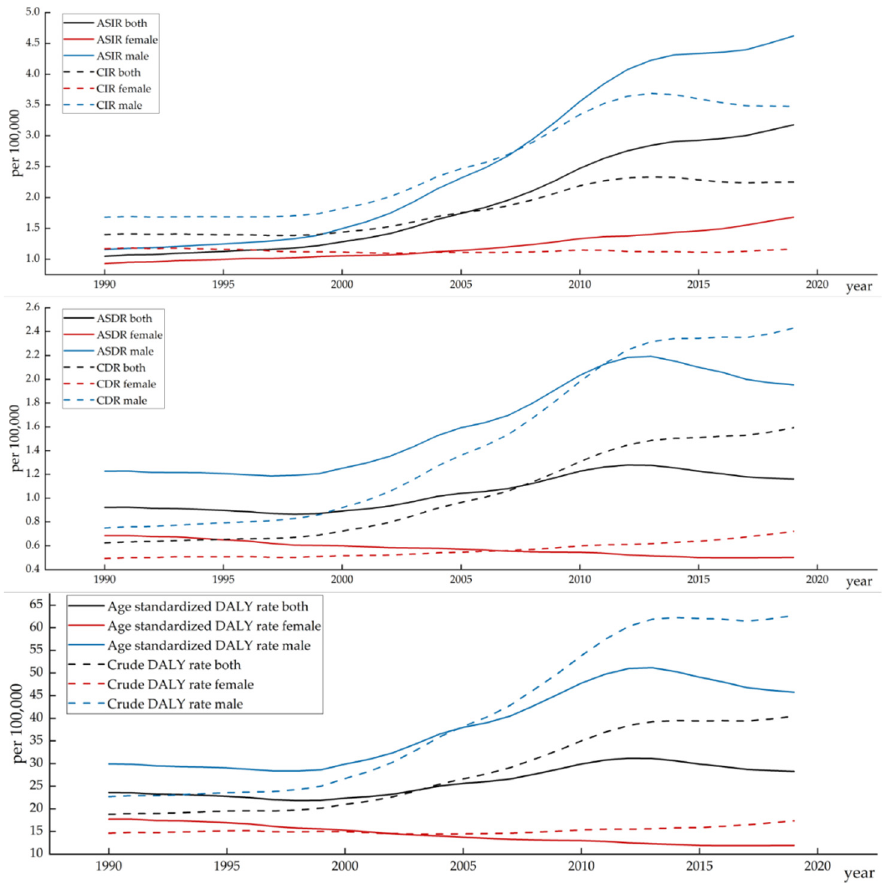
Figure 2. Trends of lip and oral cavity cancer burden in China from 1990 to 2019.